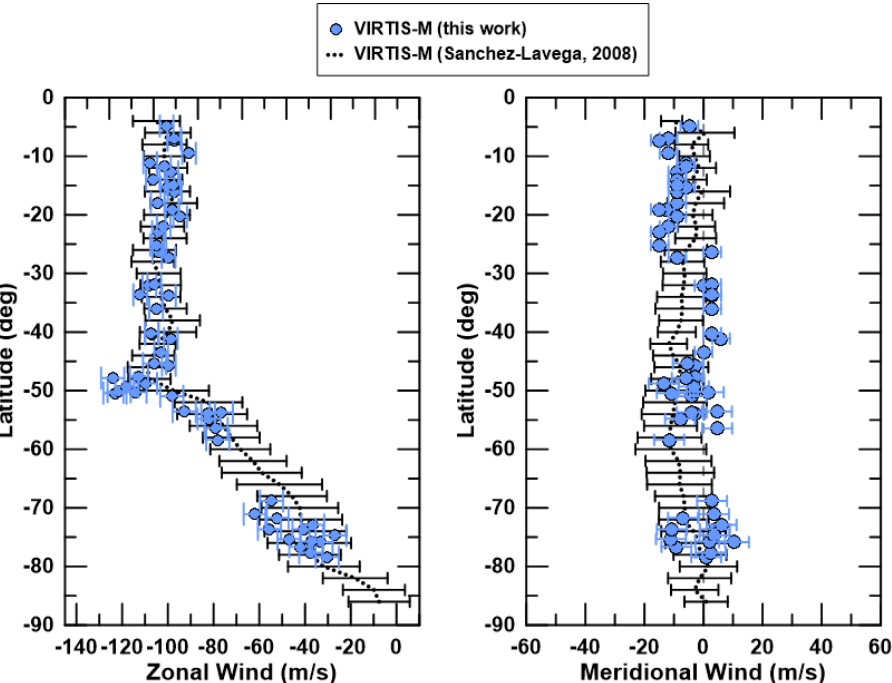
Figure 6. Latitudinal profile of the cloud-tracked zonal and meridional wind results (m · s − 1 ) obtained from our coordinated space-based observations with VEx/VIRTIS-M on 11 July 2012. Our individual measurements along with the corresponding error are displayed with blue circles and error bars. The black dotted line solid error bars stand for the reference profile of zonally averaged winds by Sanchez-Lavega et al. [5], covering winds from April 2006 to June